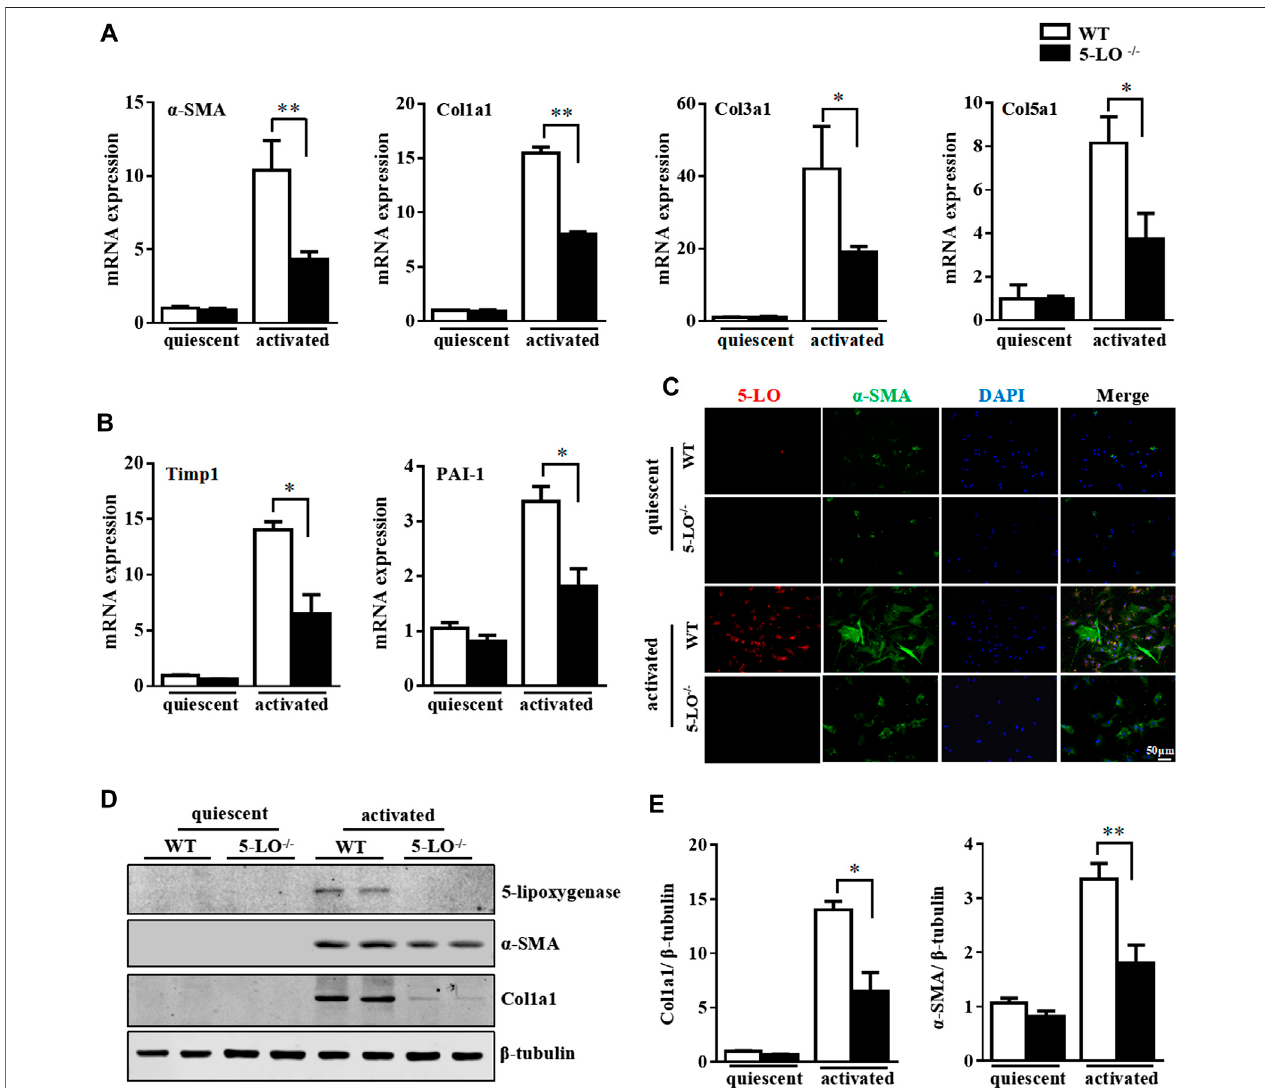
FIGURE4| Geneticablation of5-LOrestrainedactivationofprimaryHSC.PrimaryHSCwereisolatedfromWTand5-LO − / − mice. (A,B) qRT-PCRofmRNAlevels of fi brosis genes. (C) Immuno fl uorescence analysis of effect of 5-LO ablation on α -SMA expression. (D,E) Western blot analysis of α -SMA and Col1a1 protein levels in q-HSC and a-HSC. Data are mean ± SEM, n (cid:2) 5, * p < 0.05, ** p < 0.01.